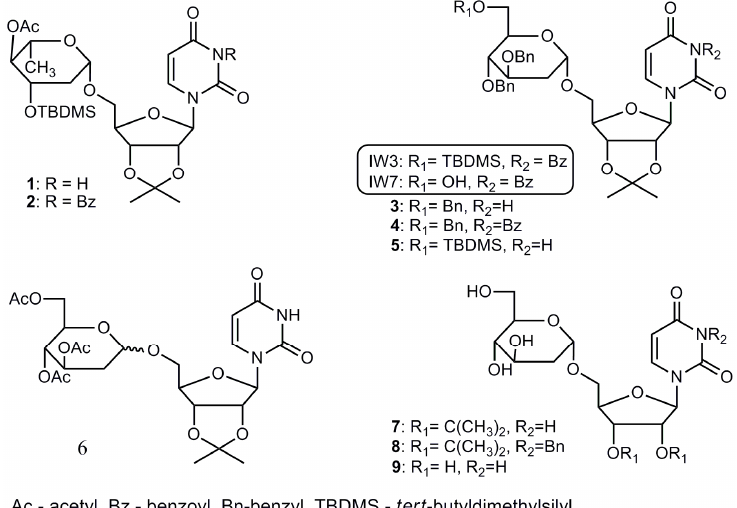
Figure 1. Structures of 2-deoxy sugar derivatives of uridine active against influenza A virus.